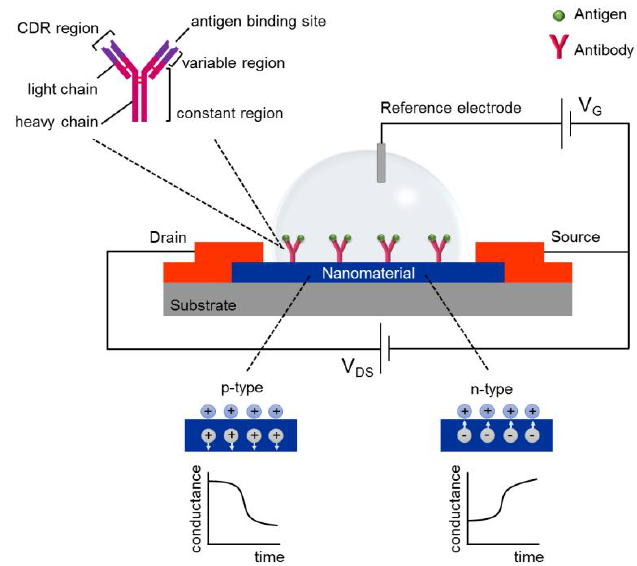
Figure 1. Scheme outlining an immunoFET operating in solution. Top-left inset represents an antibody structure, which is basically composed of two light and two heavy chains linked by disulfide bonds (red lines). Nanomaterials are embedded on the gate region as the semiconductor channel of a FET-based biosensor. Specific antibodies for antigen recognition are immobilized on the nanomaterial surface. The binding of positively charged target molecules on a p-type channel causes depletion of charge carriers (holes) and decrease in conductance, while in an n-type channel, the positively charged molecules result in accumulation of charge carriers (electrons) and increase in conductance.